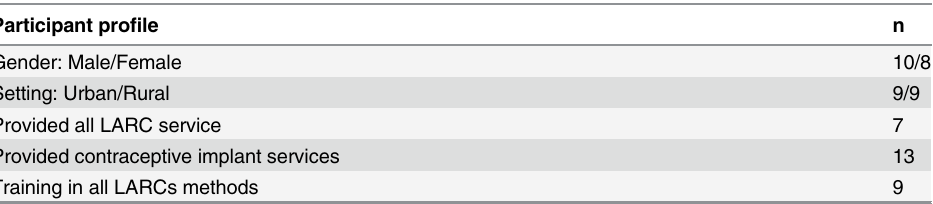
Table 3. GPs in the study (n =